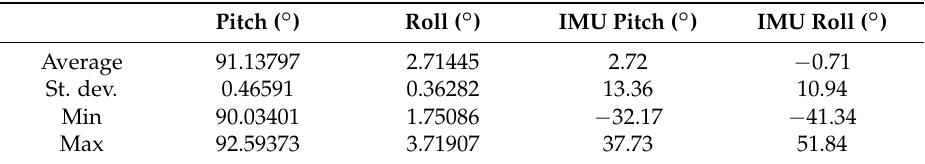
Table 2. Statistics of the Inertial Measurement Unit (IMU) and photogrammetry data for the flight simulation.